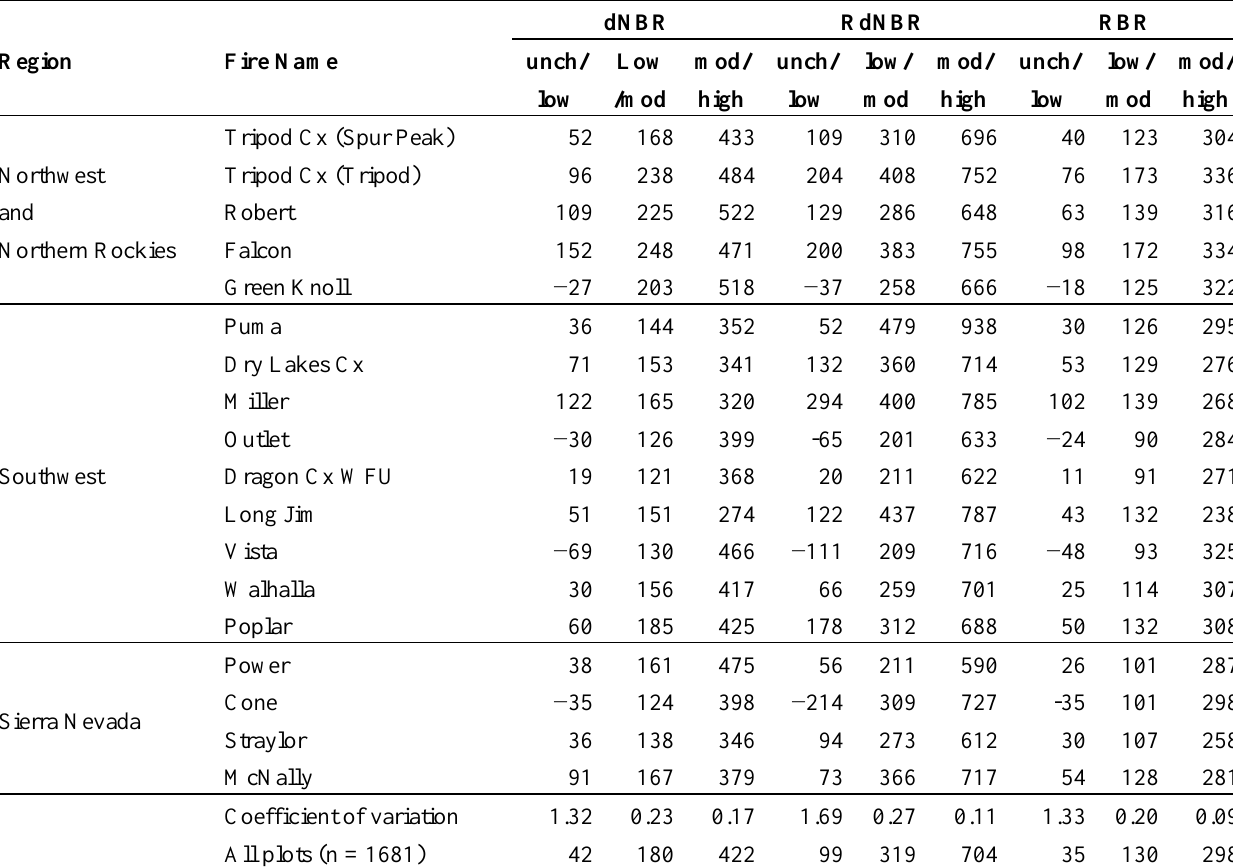
Table 3. Thresholds for the three remotely sensed burn severity metrics corresponding to CBI = 0.1 (unchanged/low), 1.25 (low/moderate) and 2.25 (moderate/high) for each fire.